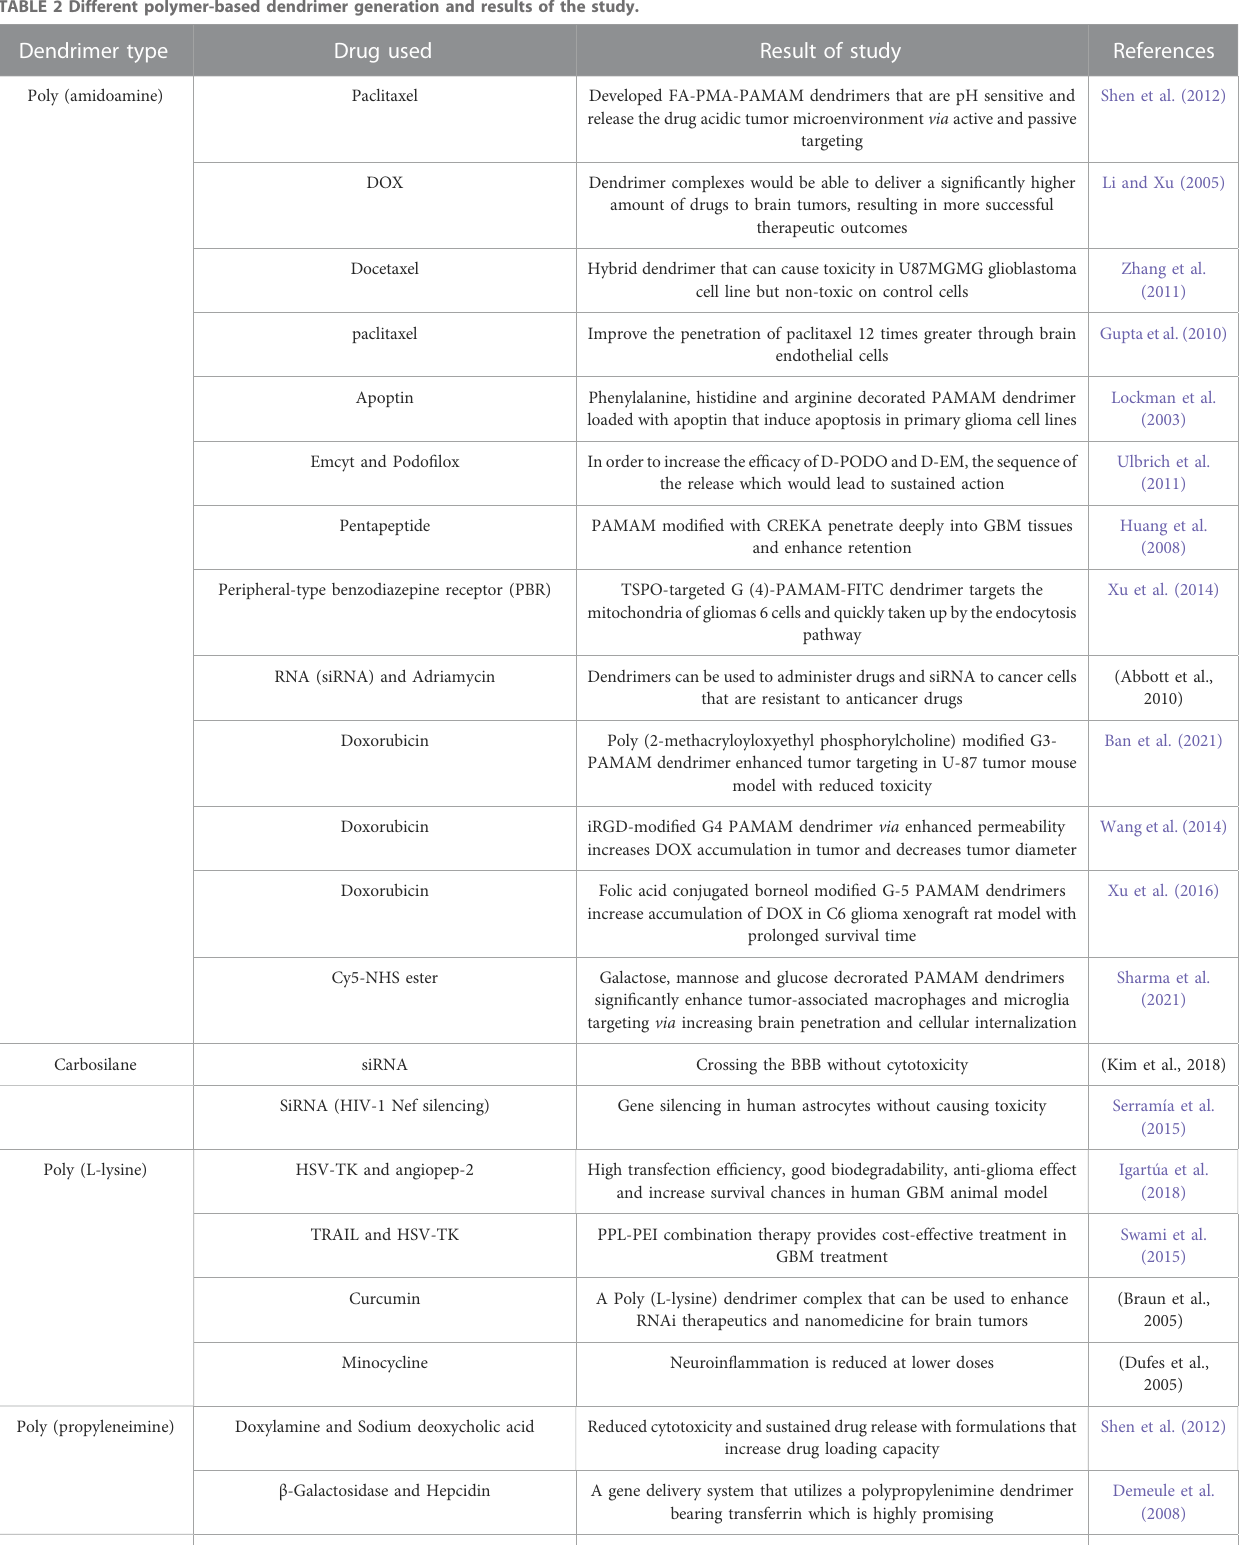
TABLE 2 Different polymer-based dendrimer generation and results of the